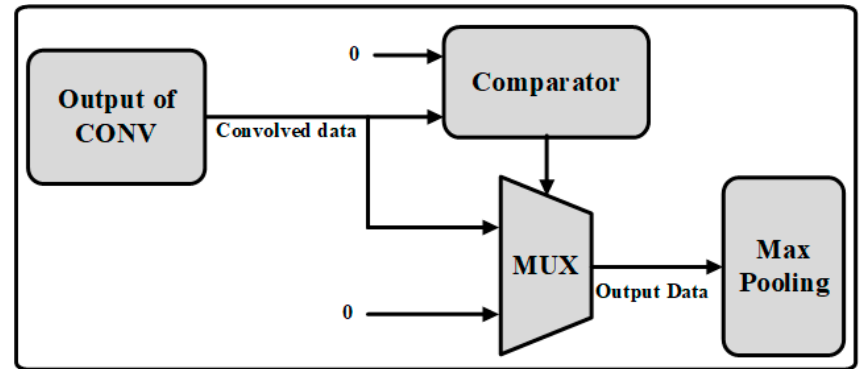
Figure 9. The architecture of convolutional operation.